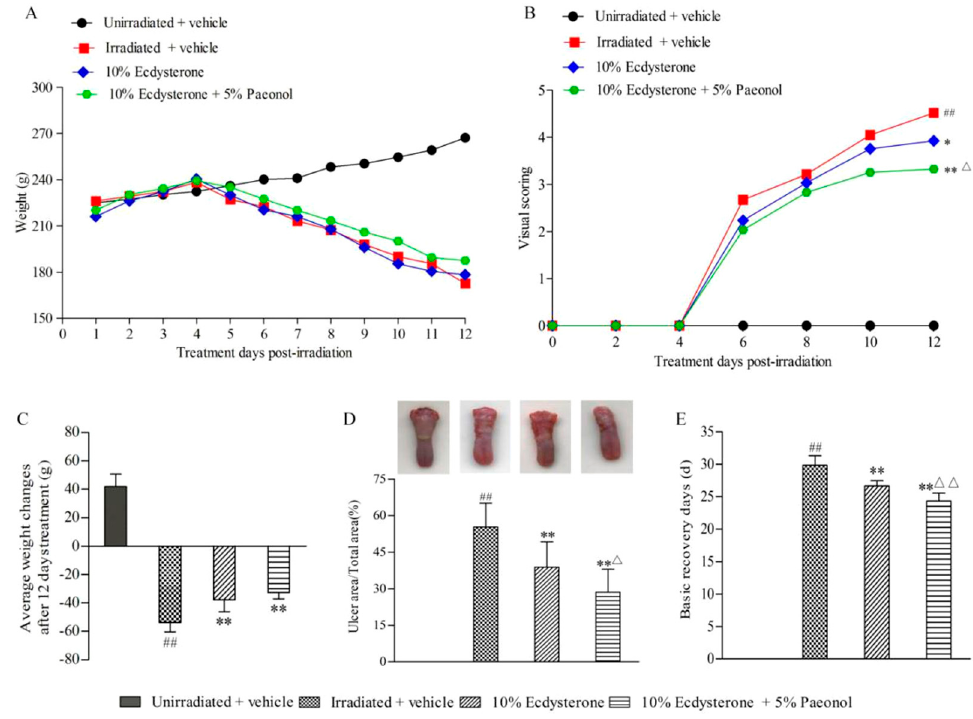
Figure 3. Development of oral mucositis following 12 days of treatment, and basic recovery days after the whole treatment: A ) Daily weights (g) for the unirradiated + vehicle, irradiation + vehicle, 10% Ecdysterone, and 10% Ecdysterone + 5% Paeonol groups are shown throughout 12 days of treatment, post-irradiation; B ) Average visual scoring ( n = 6 rats) are shown for every 2nd day throughout 12 days of treatment, post-irradiation ( ## p < 0.01 vs. the unirradiated + vehicle group; ** p < 0.01, * p < 0.05 vs. the irradiated + vehicle group; △ p < 0.05 vs. 10% Ecdysterone group after 12 days of treatment; n = 6 rats); C ) Average weight changes after 12 days of treatment post-irradiation ( ## p < 0.01 vs. the unirradiated + vehicle group; ** p < 0.01 vs. the irradiated + vehicle group; n = 6 rats); D ) Representative images and a figure showing the ratio (%) of ulcer area/total area after 12 days of treatment. The unirradiated + vehicle, irradiated + vehicle, 10% Ecdysterone, and 10% Ecdysterone + 5% Paeonol groups are shown (below) ( ## p < 0.01 vs. the unirradiated + vehicle group; ** p < 0.01 vs. the irradiated + vehicle group; △ p < 0.05 vs. the 10% Ecdysterone group; n = 6 rats). E ) Basic recovery days after the whole treatment of each group. ( ## p < 0.01 vs. the unirradiated + vehicle group; ** p < 0.01 vs. the irradiated + vehicle group; △△ p < 0.01 vs. the 10% Ecdysterone group; n = 6 rats).